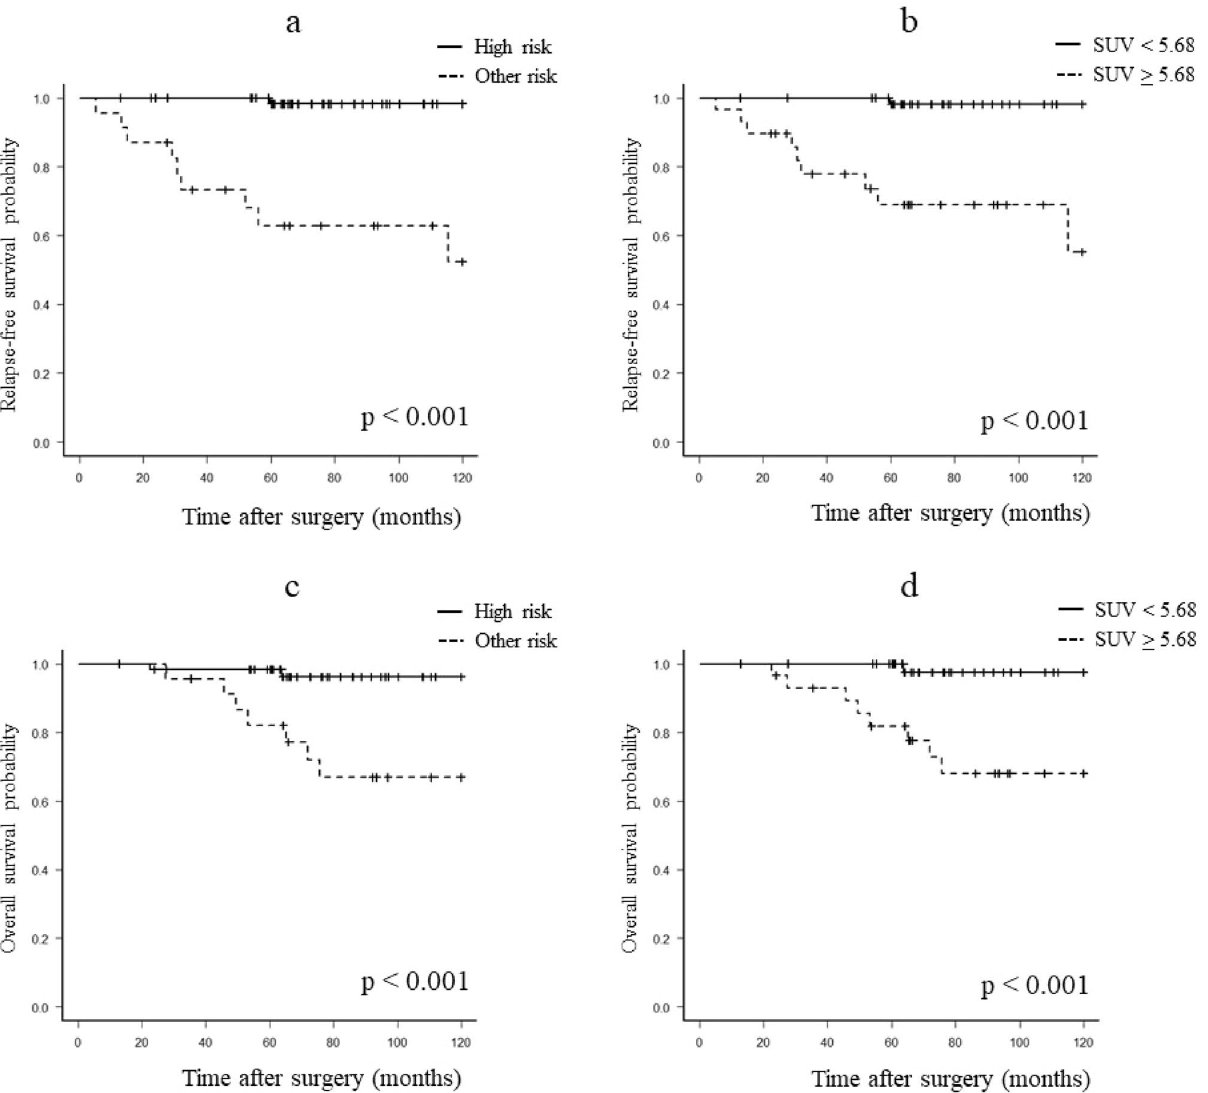
Figure 6. Survival curves of relapse-free survival and overall survival. ( a ) Relapse-free survival of patients with high risk- and other-risk groups using the log-rank test ( P < 0.001). ( b ) Relapse-free survival of patients with SUVmax ≥ 5.68 and < 5.68 using the log-rank test ( P < 0.001). ( c ) Overall survival of patients with high risk- and other-risk groups using the log-rank test ( P < 0.001). ( d ) Overall survival of patients with SUVmax ≥ 5.68 and < 5.68 using the log-rank test ( P <